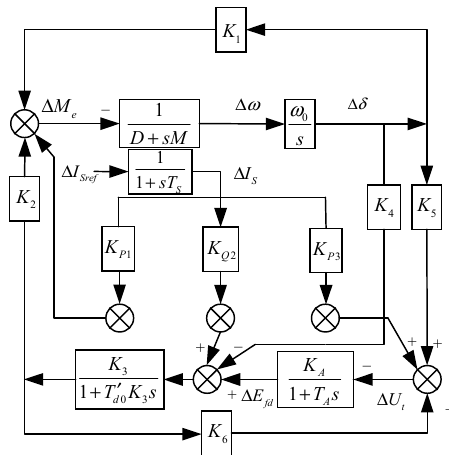
Figure 2. Philips–Heffron model based on flexible excitation system.